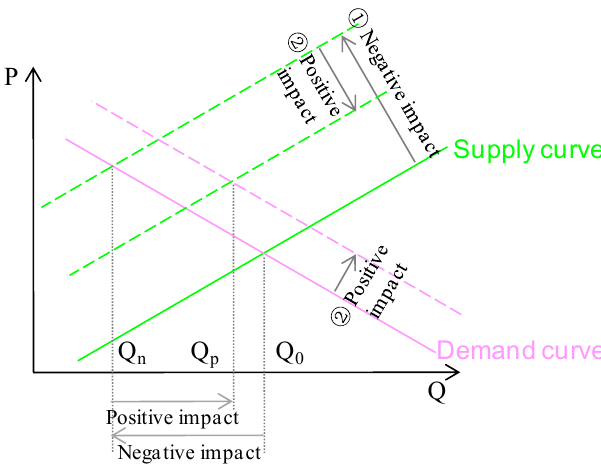
Fig. 1. The mechanism of negative impacts of disasters and positive impacts of disaster-proof reconstruction on the social economy.